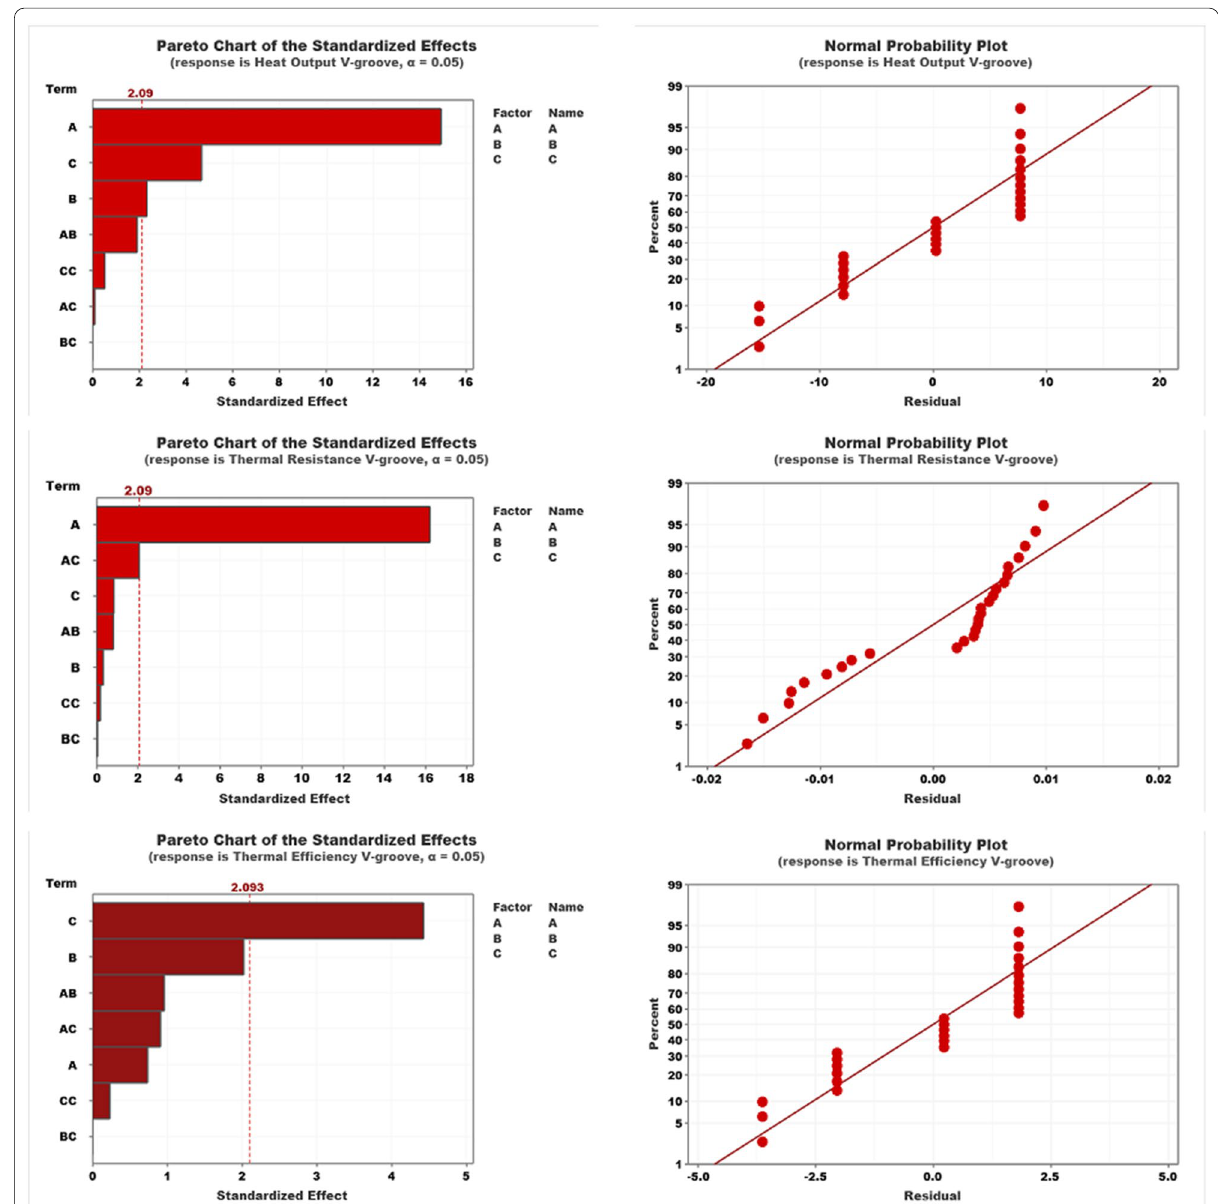
Fig. 3. Plots of ( a ) Pareto chart and ( b ) normal probability for response characteristics of a V-grooved